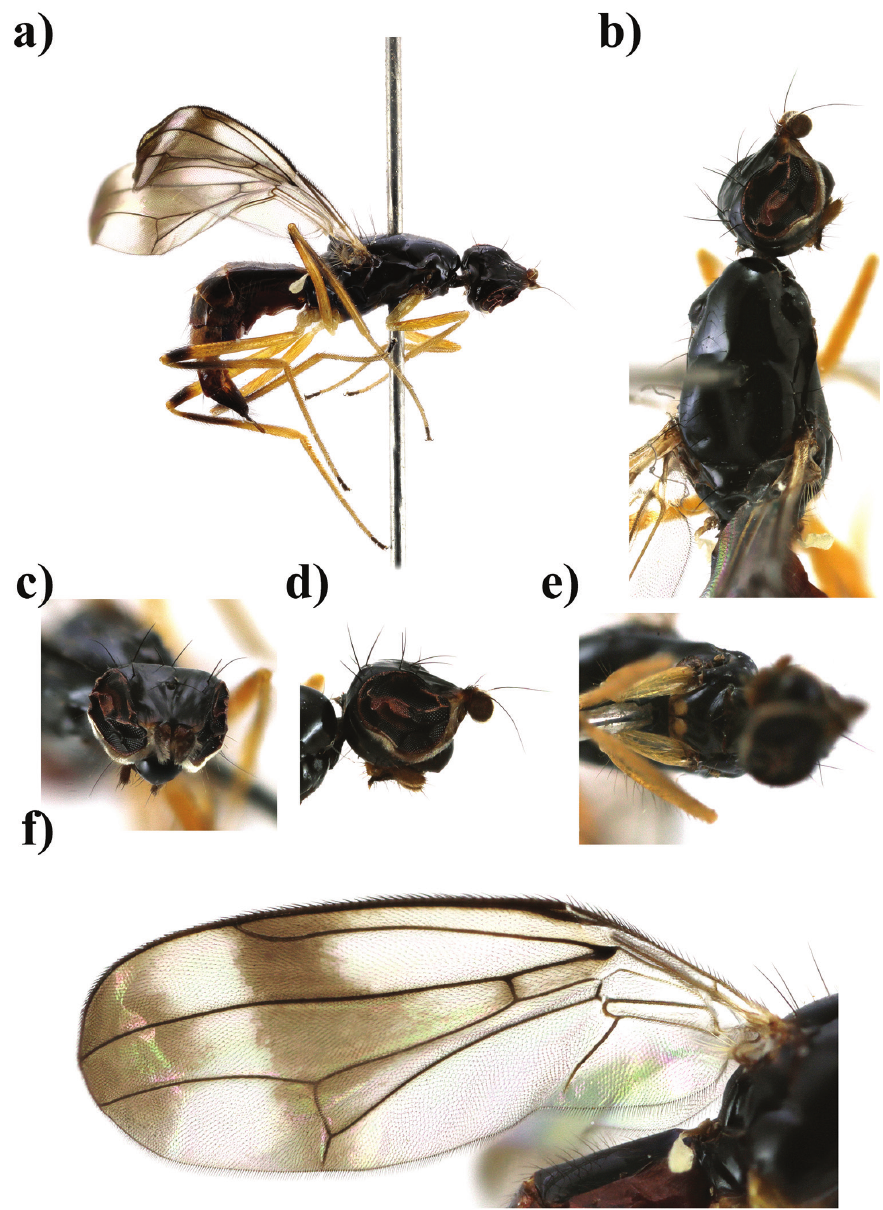
Figure 2. Strongylophthalmyia basisterna sp. n. a habitus, lateral view b head and thorax, dorsal view c head, anterior view d head, lateral view e basisternum f